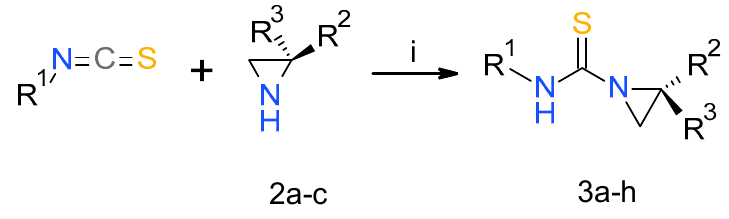
Figure. 2. Reagents and conditions : (i) CH 2 Cl 2 , 30 min to 16 h. Figure 2. Reagents and conditions : (i) CH 2 Cl 2 , 30 min to 16 h. Table 1. Yields of the new urea and thiourea derivatives 3a – 3h . Table 1. Yields of the new urea and thiourea derivatives 3a – 3h